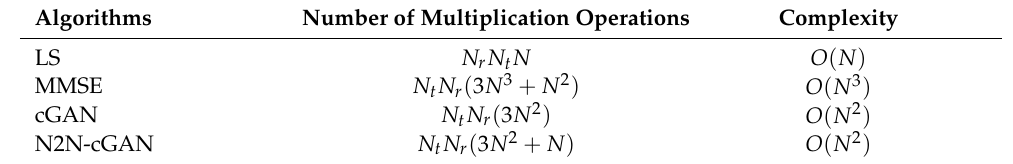
Figure 8. Different algorithms’ NMSE performances with the number of base station antennae. Table 2. Computational complexity. Algorithms Number of Multiplication